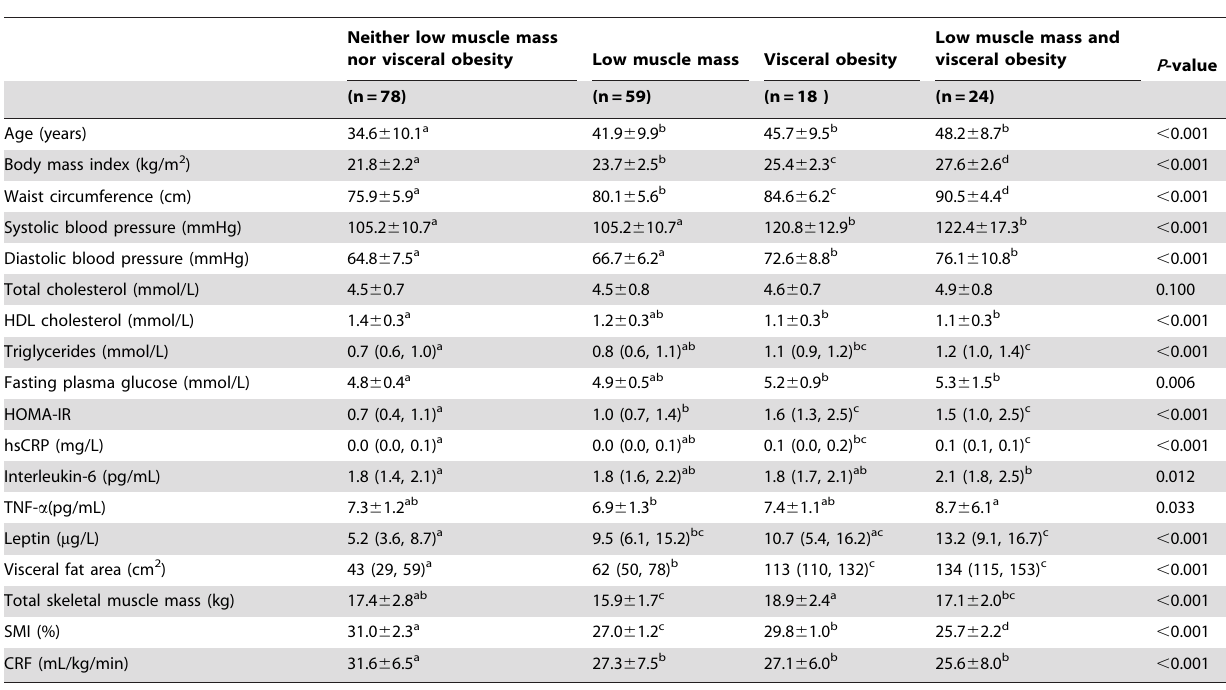
Table 1 . Clinical, anthropometric, and metabolic characteristics of female study subjects.